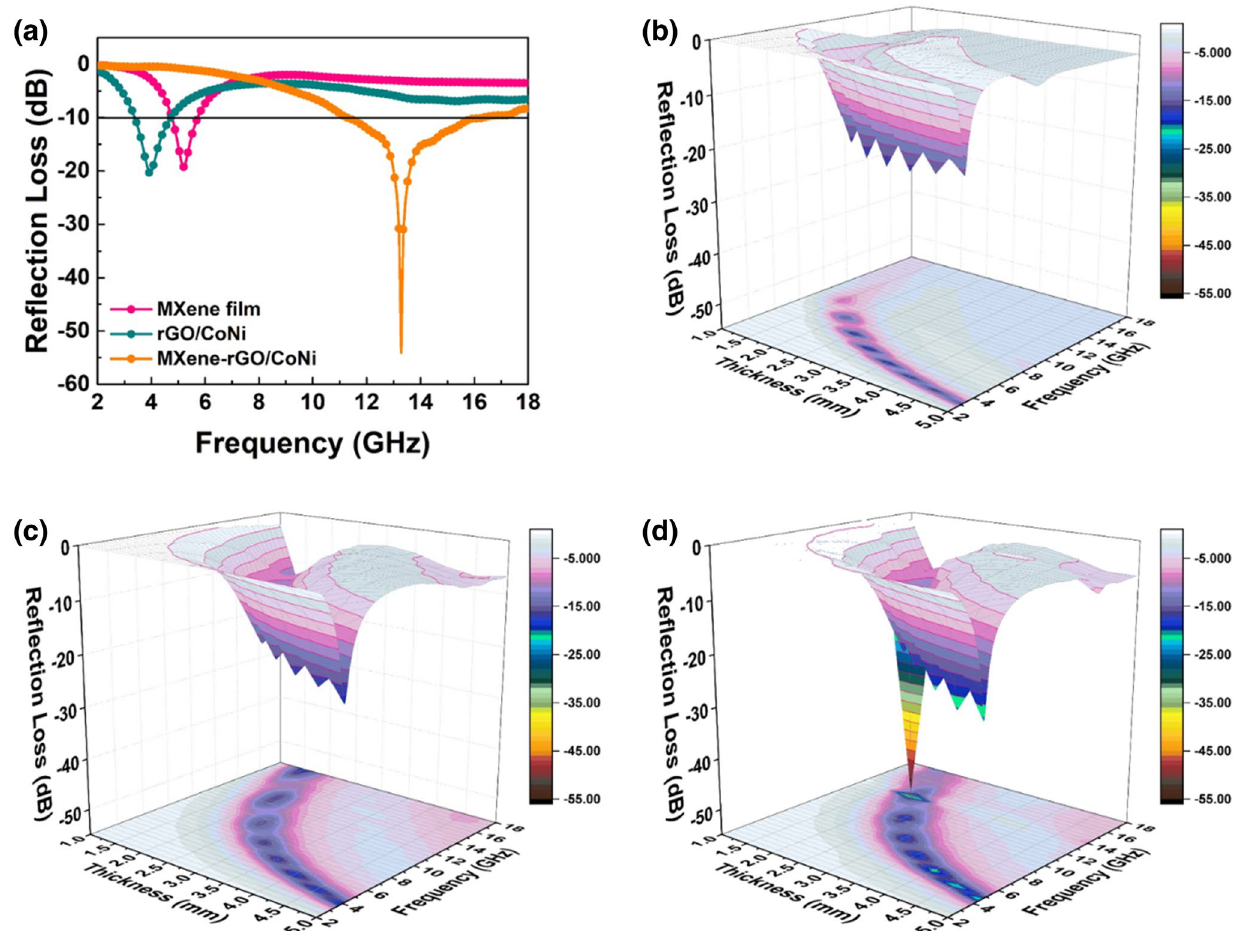
Fig. 5 a Three samples with their respective highest RL values; 3D plots of RL of b MXene, c rGO/CoNi, d MXene-rGO/CoNi